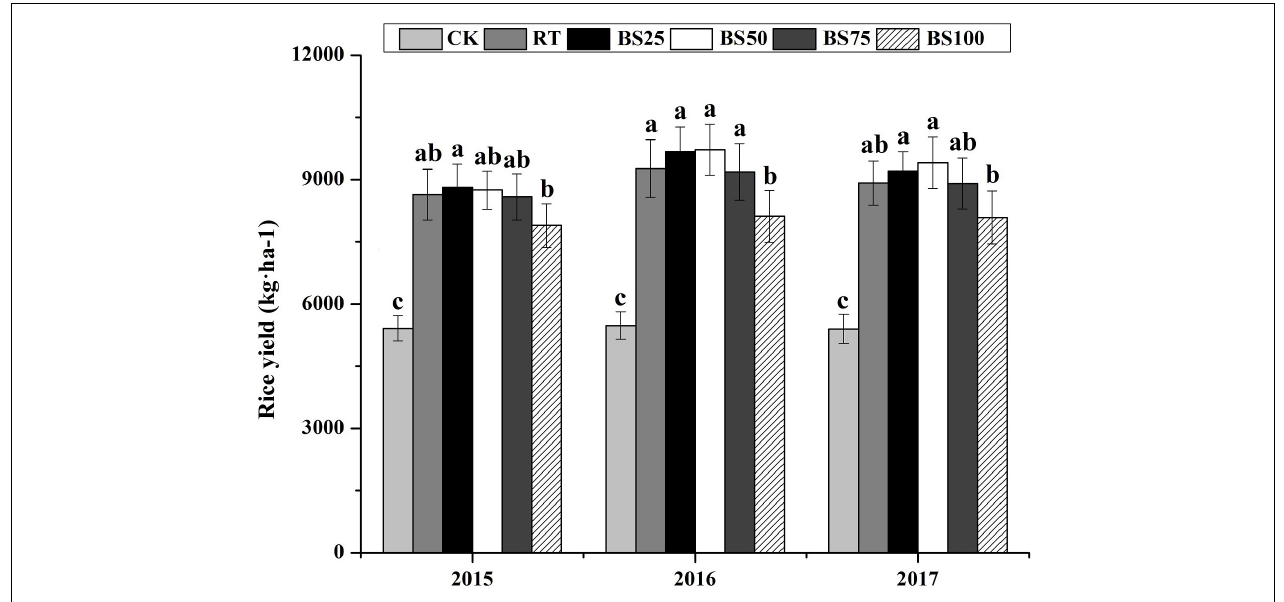
FIGURE 1 | Rice yields in different treatments during 2015–2017. Different letters above the columns indicate significant differences at P < 0.05.